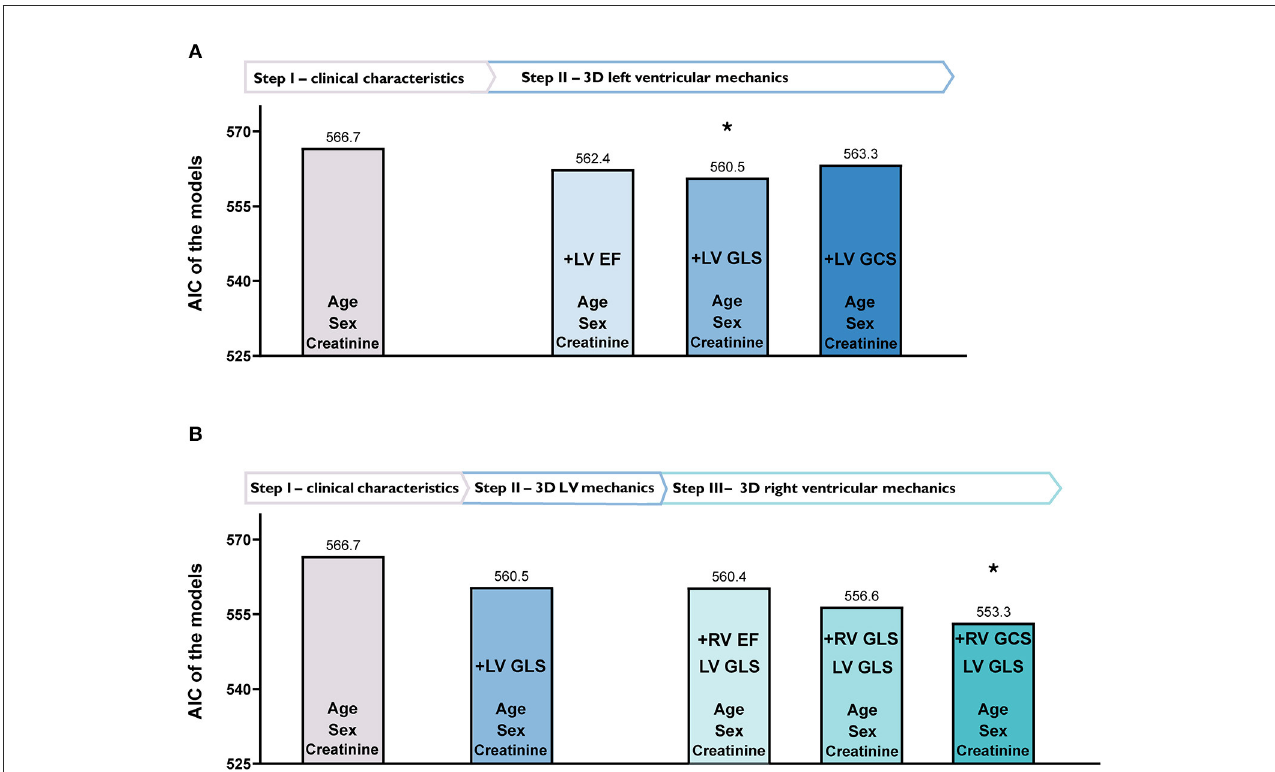
FIGURE1 Identification of the best-fit models, including left (LV) and right ventricular (RV) functional parameters by multivariable Cox regression analysis based on Akaike Information Criterion (AIC). (A) Depicts different models with only clinical characteristics (Step I) and 3D LV mechanical parameters added one by one (Step II). In Step II, adding LV global longitudinal strain (GLS) to the model resulted in the lowest (best) AIC value. (B) Shows the added value of 3D RV mechanical parameters (Step III). In Step III, adding RV global circumferential strain (GCS) to the previously established model in Step II (clinical characteristics and LV GLS) resulted in the best fit to our data as confirmed by the lowest AIC